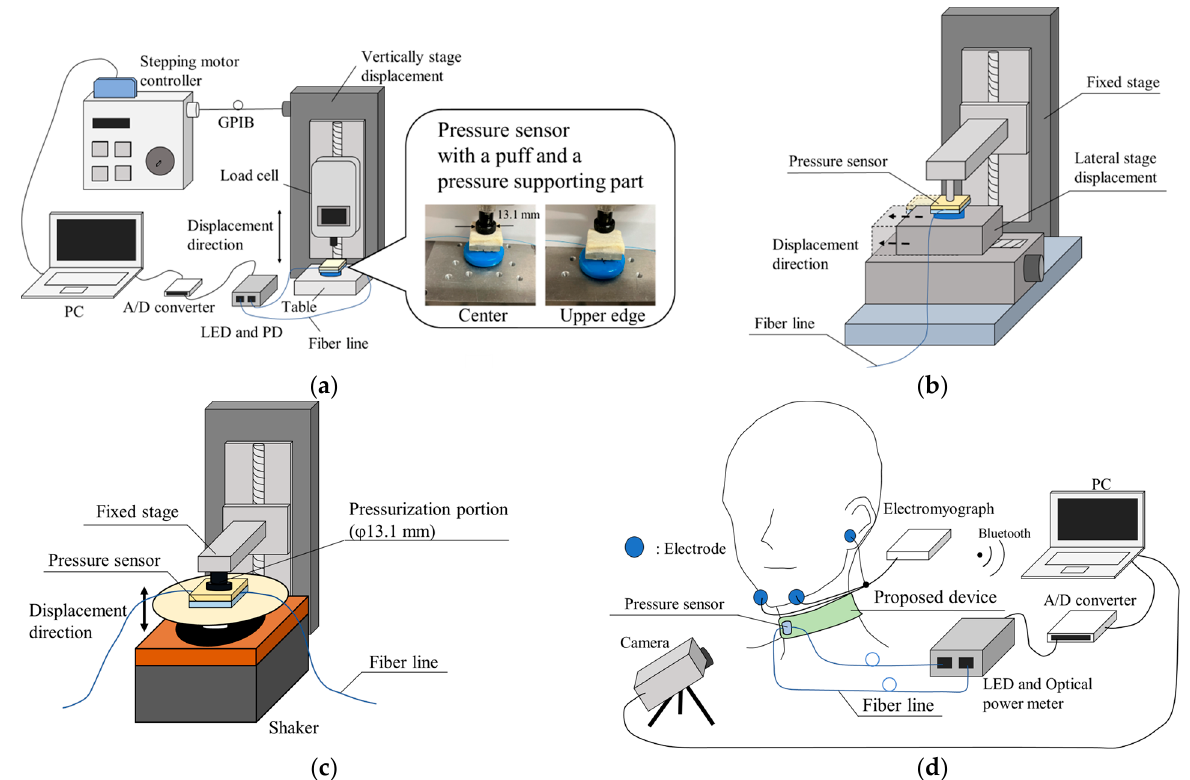
Figure 4. Experimental setup: ( a ) for measuring the pressure characteristics of the pressure sensor; ( b ) for evaluating the sensitivity characteristic with respect to the axial displacement of the applied pressure from the center to the edges of the pressure sensor’s surface; ( c ) for measuring the dynamic characteristics of the pressure sensor; ( d ) for evaluating the response of the proposed wearable swallowing assessment device to laryngeal movement.